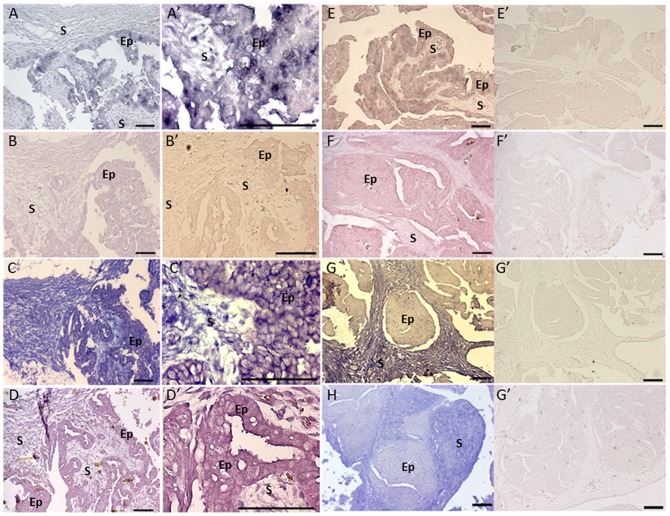

L1, PIWIL1, MAEL and PIWIL2 are expressed in the epithelial cells of malignant EOC.
In situ analysis of (A, A’, E) L1, (B, B’, F) PIWIL1, (C, C’, G) MAEL, (D, D’, H) PIWIL2 in two malignant EOC (A-D from SC3 while E-H from SC2). (A’-D’) Amplification images of A-D respectively. Strong expression of piRNA pathway genes and L1 was found in the squamous-to-cuboidal like epithelial cells of both malignant EOC except PIWIL1 which only expressed in SC2 but not SC3. L1 has patchy expression in some EOC such that some epithelial cells seem to have stronger L1 expression compared to others. MAEL and PIWIL2 but not PIWIL1 are also expressed in the stromal cells in both EOC. (E’-H’) Negative controls with sense probe of L1, PIWIL1, MAEL and PIWIL2 respectively. Ep  =  epithelial cells; S  =  stromal cells. Scale bar  =  50µm.